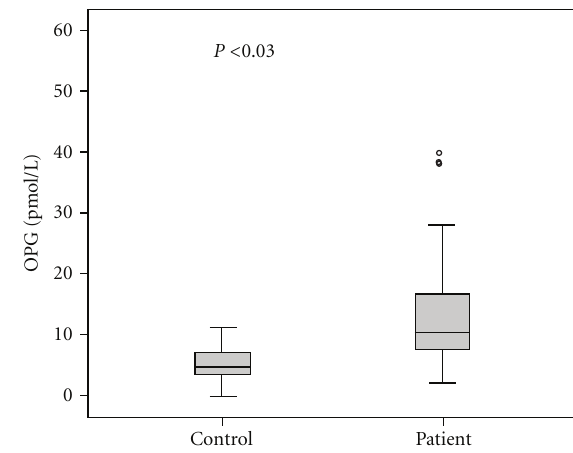
Figure 1: Serum OPG concentrations in MM patients and healthy controls.